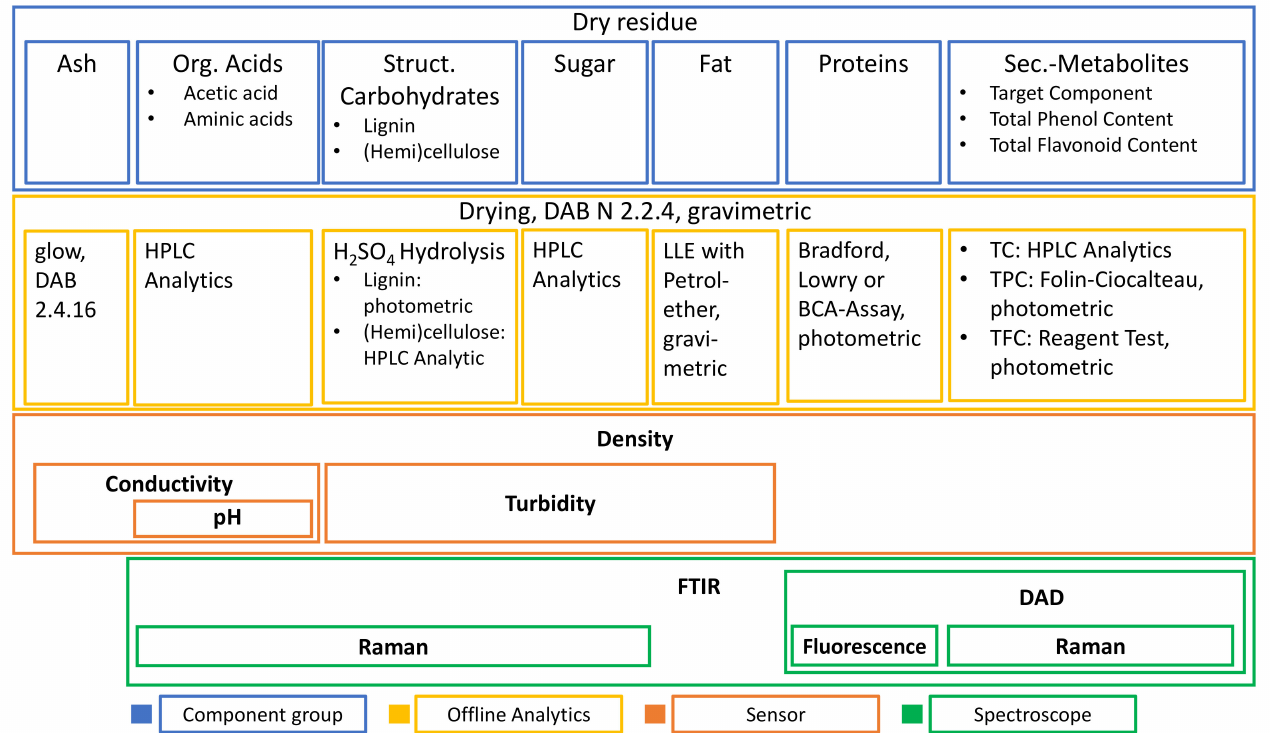
Figure 2. Overview of systematic approach on development of a PAT concept for complex mixtures with postulated sensor and spectroscopy